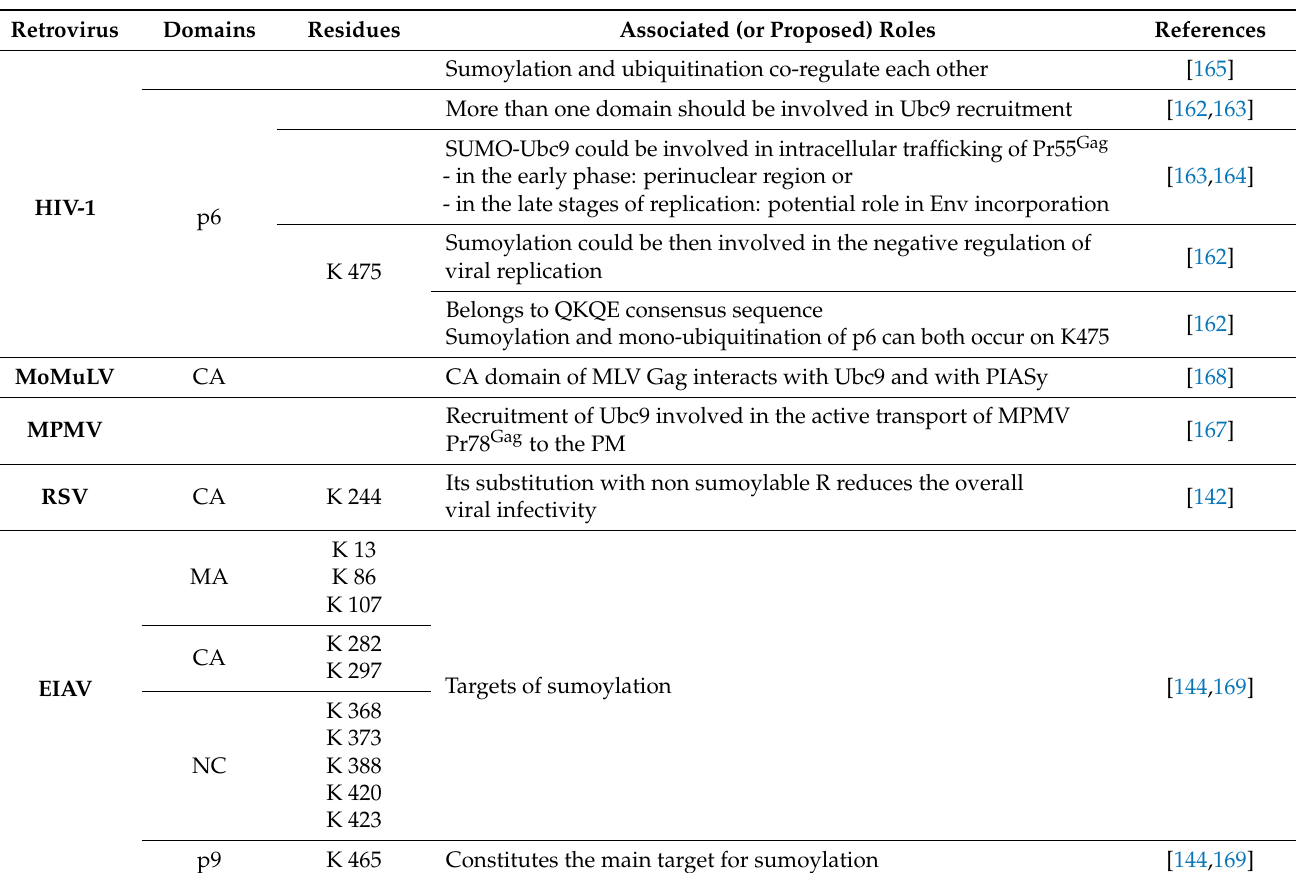
Table 5. Summary of sumoylated positions in retroviral Gag